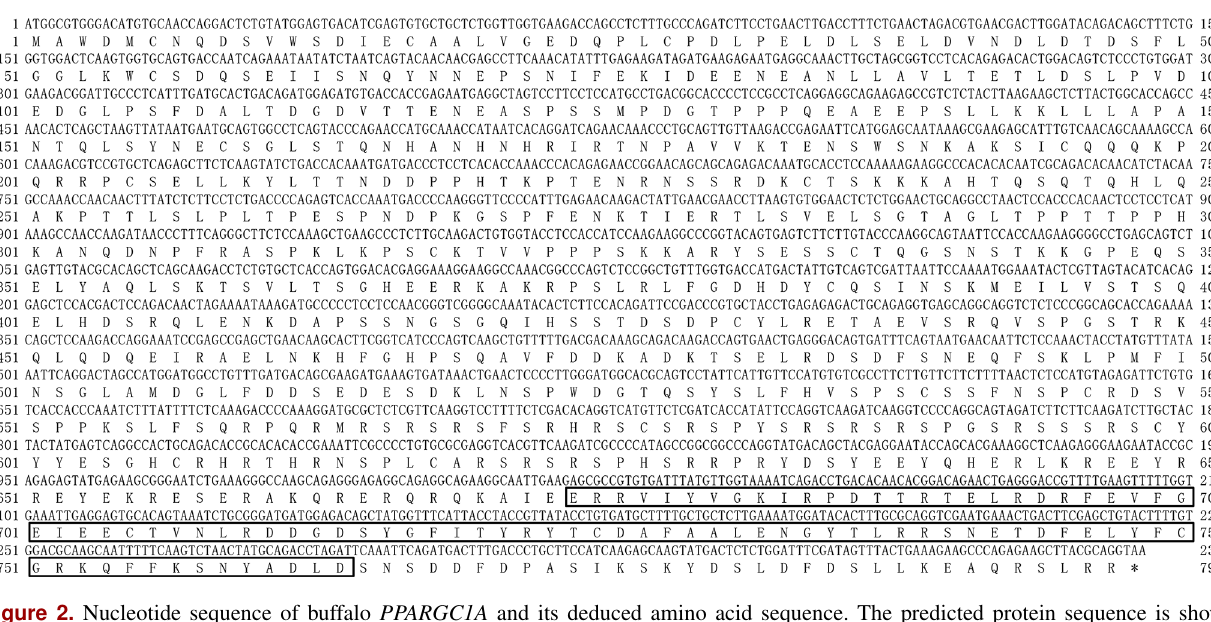
Figure 2. Nucleotide sequence of buffalo PPARGC1A and its deduced amino acid sequence. The predicted protein sequence is shown immediately above the nucleotide sequence. The RRM_PPARGC1A domain (AA 674–764) is boxed. The stop codon is indicated by an asterisk ( ∗ ). Table 2. Physicochemical characteristics of PPARGC1A for buffalo and cattle. Basic physical and chemical